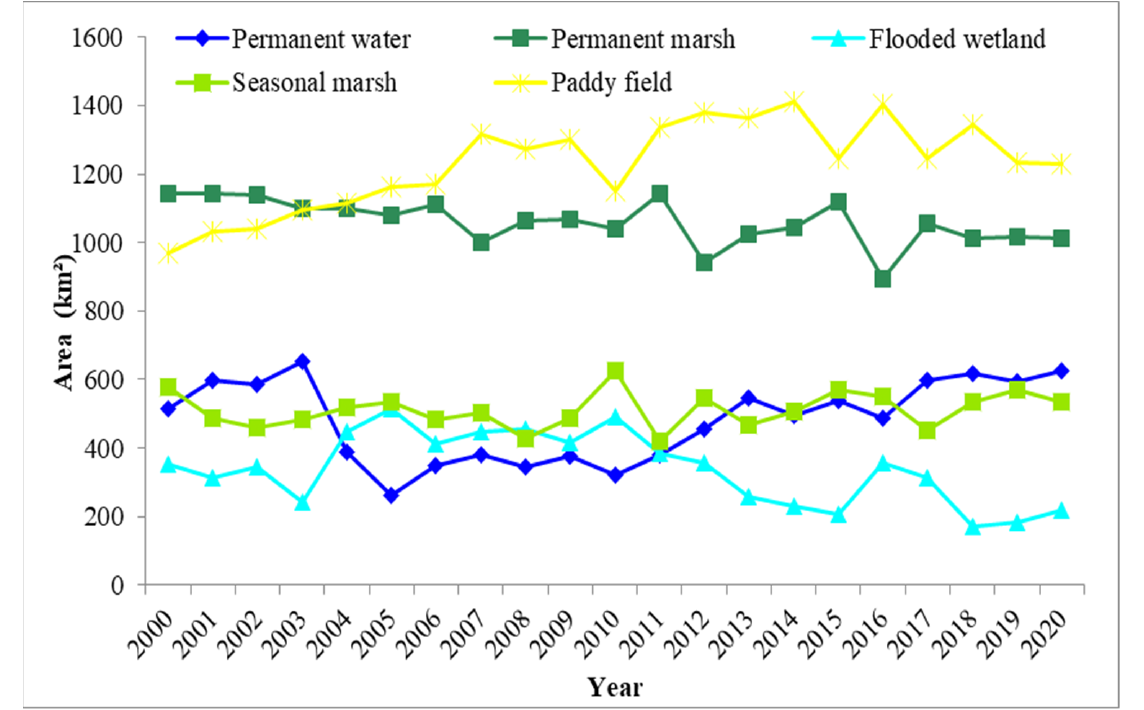
Figure 12. Dynamic changes in the three Dongting Lake wetland reserves from 2000 to 2020.